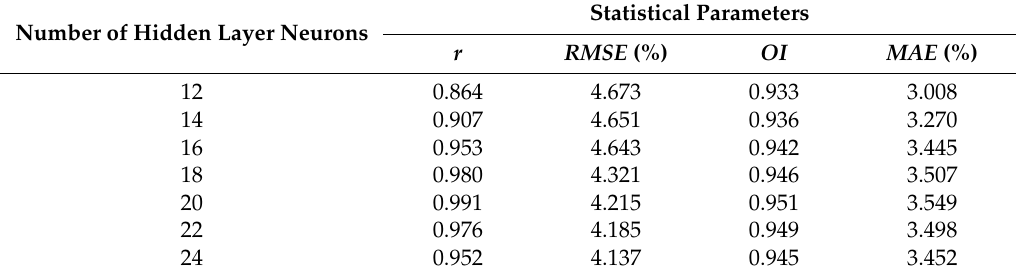
Table 3. Statistical performance of BP neural network model with different numbers of hidden layer neurons. Number of Hidden Layer Neurons